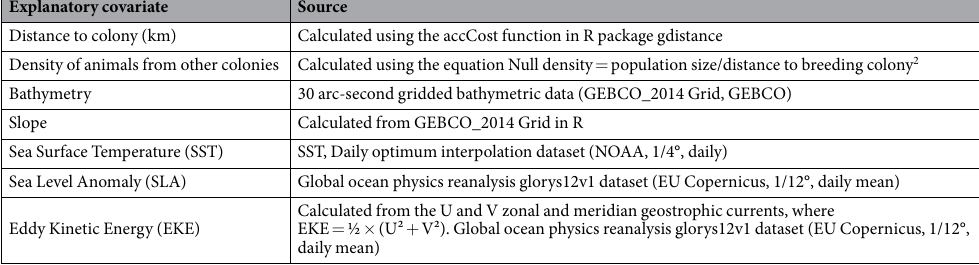
Table 3. List of static and dynamic explanatory covariates used to model and predict the distribution of marine predators breeding at the Falkland